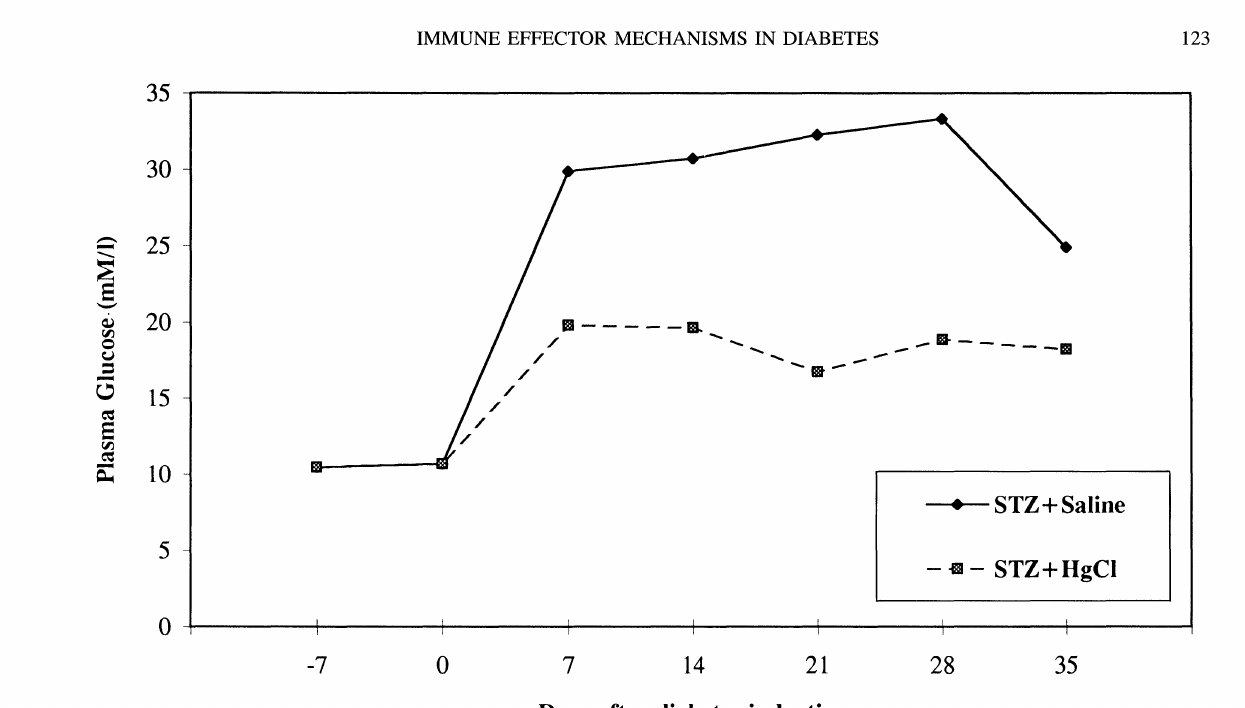
FIGURE 2 MLD-STZ-induced diabetes in mercury-treated rats. Rats were pretreated with HgC12 (1 mg/kg b.w. in 2-day intervals) from days -6 to 2 in relation to MLD-STZ-diabetes induction (20 mg/kg b.w. for five consecutive